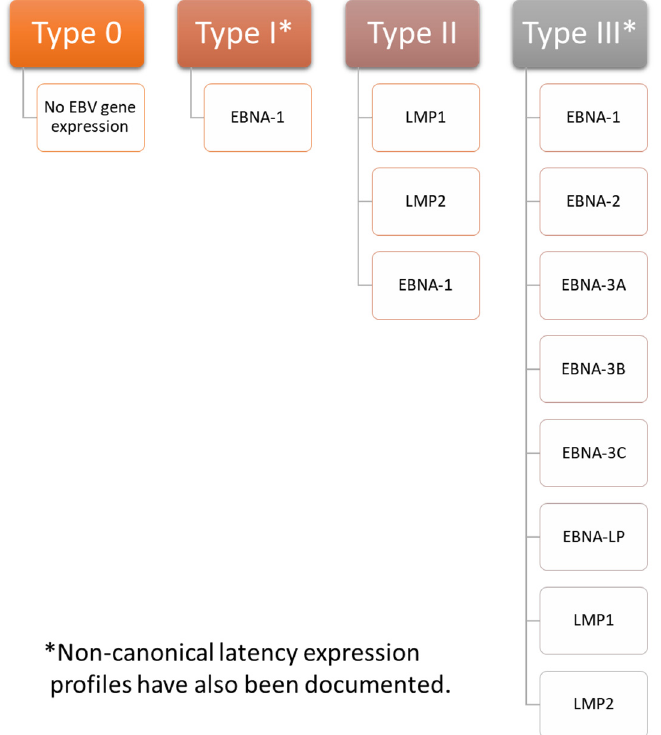
Figure 1. EBV Latency Types. EBV has four gene expression profiles during latent infection: type 0, type I, type II, and type III. In type 0 latency EBV, few, if any, proteins are expressed. Epstein-Barr nuclear antigen (EBNA)-1 is the only protein expressed during type I latency. Latent membrane protein (LMP) 1, LMP2, and EBNA-1 are all expressed during type II latency. All genes associated with latency are expressed in type III latency, including EBNA-1, EBNA-2, EBNA-3A, EBNA-3B, EBNA-3C, EBNA-LP (leader protein), LMP1, and LMP2. These proteins play important roles in maintaining latency. Notably, non-canonical latency expression profiles have also been documented. For example, infected cells expressing a type I latency profile may also express LMP1 or LMP2A, and infected cells expressing a type III latency profile may not express EBNA-2. Few, if any, proteins are expressed during type 0 latency. EBNA-1 is the primary viral